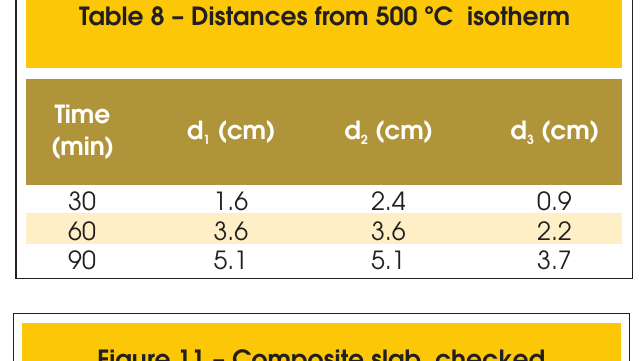
Table 6 – Maximum and average temperatures on slab's upper face with 7 and 8 cm flange